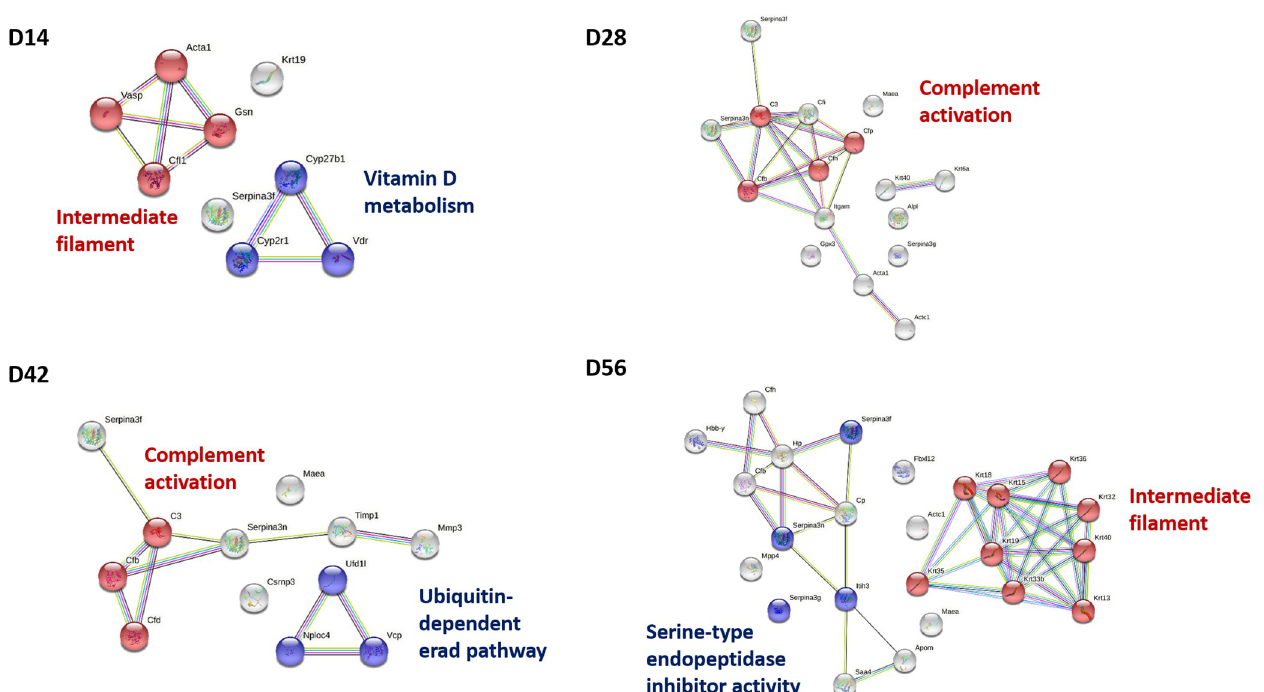
Fig 4. Protein-protein interactions of up-regulated and down-regulated S . mekongi -infected mouse serum proteins at 14-, 28-, 42-, and 56-days post- infection. The protein-protein interaction network was created using String database. Red and blue nodes indicate proteins in each pathway predicted to be altered with S . mekongi infection. Color nodes (red and blue) represent query proteins with first shell of interactors. White nodes represent proteins with second shell of interactors. Empty nodes indicate unknown 3D structural protein. Filled nodes indicate proteins with known or predicted 3D structure. Edges represent protein-protein associations with different types; red line: presence of fusion evidence; green line: neighborhood evidence; blue line: cooccurrence evidence; purple line: experimental evidence; yellow line: textmining evidence; light blue line: database evidence; black line: co-expression evidence. Acta1: actin alpha 1 skeletal muscle; Gsn: gelsolin; Cfl1: cofilin 1; Vasp: vasodilator stimulated phosphoprotein; Cyp27b1: cytochrome P450 family 27 subfamily B member 1; Cyp2r1: cytochrome P450 family 2 subfamily R member 1; Vdr: vitamin D receptor; C3: complement C3; Cfp: complement factor properdin; Cfh: complement factor H; Cfb: complement factor B; Cfd: complement factor D; Ufd1: ubiquitin recognition factor in ER associated degradation 1; Vcp: valosin containing protein; Nploc4: NPL4 homolog, ubiquitin recognition factor; Serpina3f: serpin clade A member 3F; Serpina3n: serpin clade A member 3N; Serpina3g: serpin clade A member 3G; Ithi3: inter-alpha-trypsin inhibitor heavy chain 3; Krt: keratin.